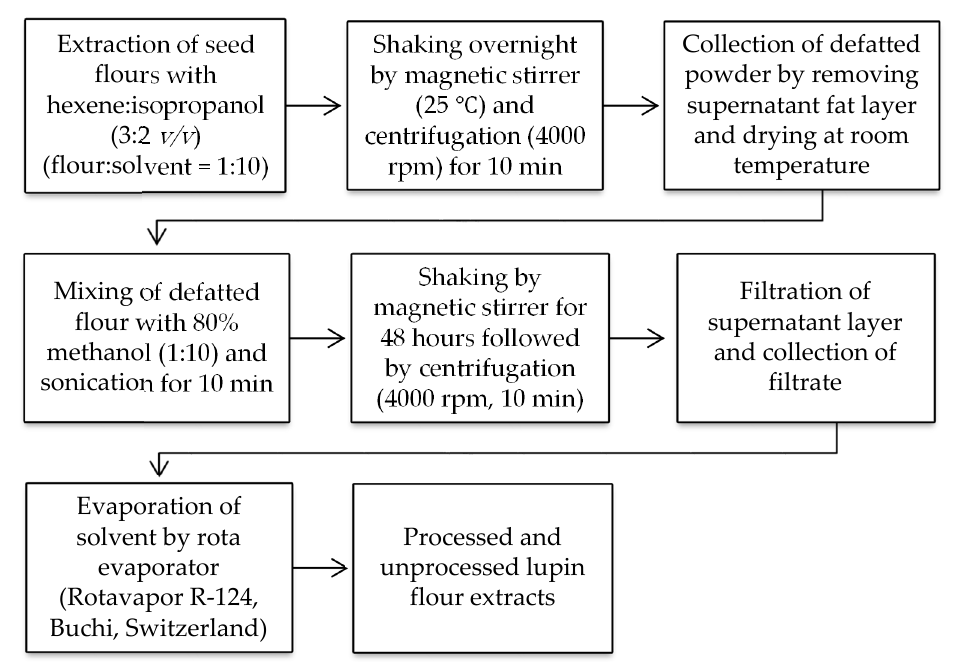
Figure 1. Schematic representation of preparation of unprocessed and processed lupin flour extract. Extraction process was carried out three times for each cultivar of both processed and unprocessed lupin flours.